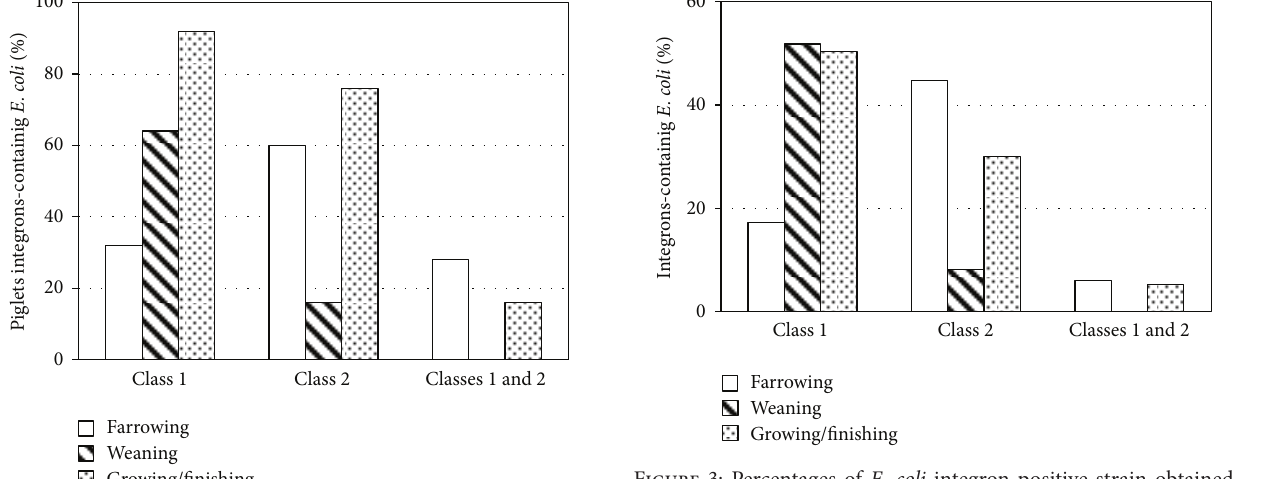
Figure 3: Percentages of E. coli integron positive strain obtained from piglets isolates at different stages of production.